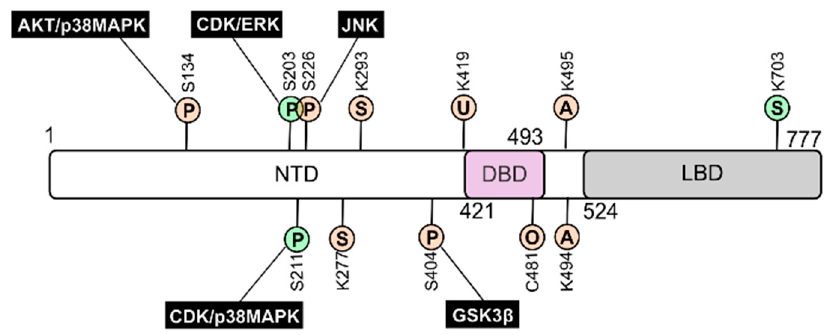
Figure 4. GR post-translational modifications: impact on receptor’s function. GR is subjected to a variety of posttranslational modifications (PTMs), which have a major impact on receptor function. Scheme indicates PTM target residues for hGR α including phosphorylation (P), acetylation (A), ubiquitination (U), SUMOylation (S), and oxidation (O). The major kinases phosphorylating GR and the outcome of the corresponding PTMs are also indicated (green, activation; salmon, inhibi- tion).